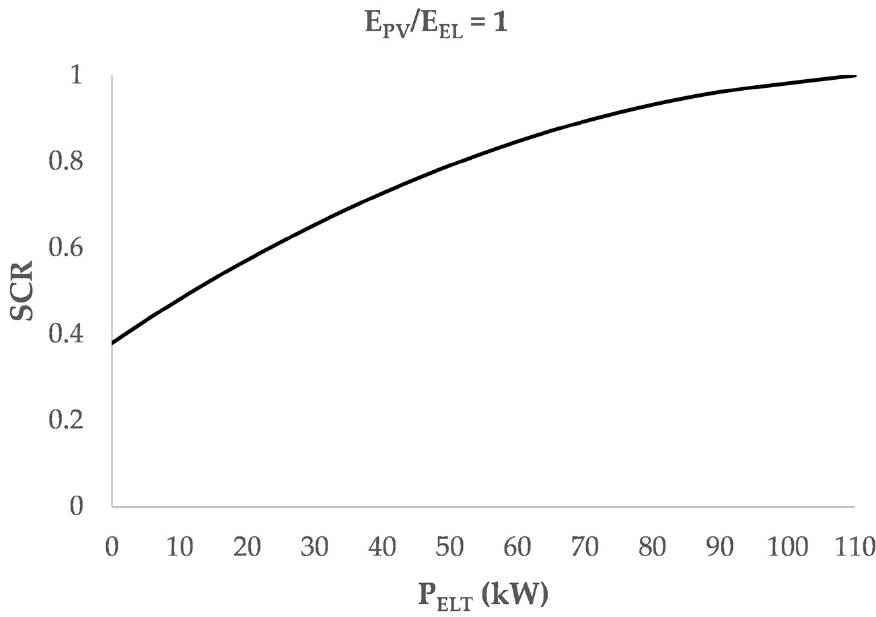
Figure 3. SCR versus the rated power of electrolyser in the scenario E PV /E EL equal to 0.5.